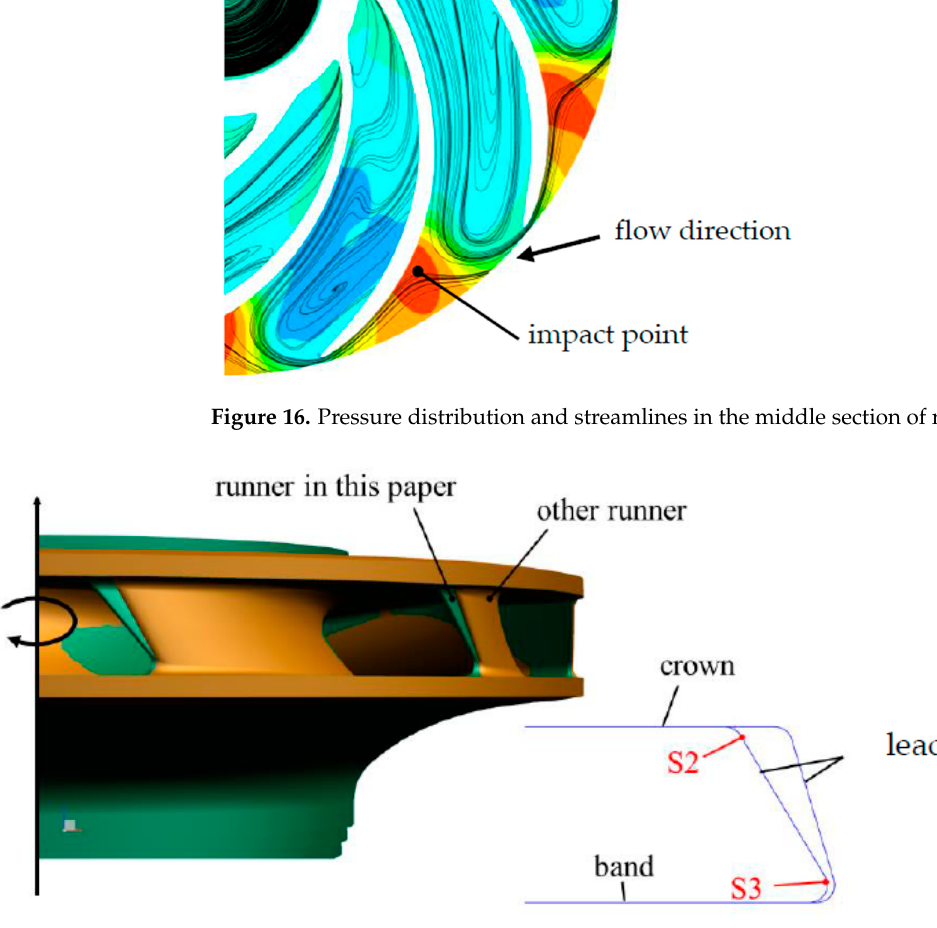
Figure 17. The leaning leading edge of runner studied in this paper.